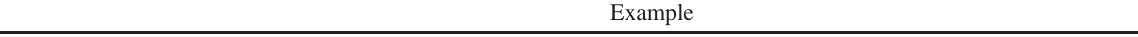
TABLE V. Themes with examples for student